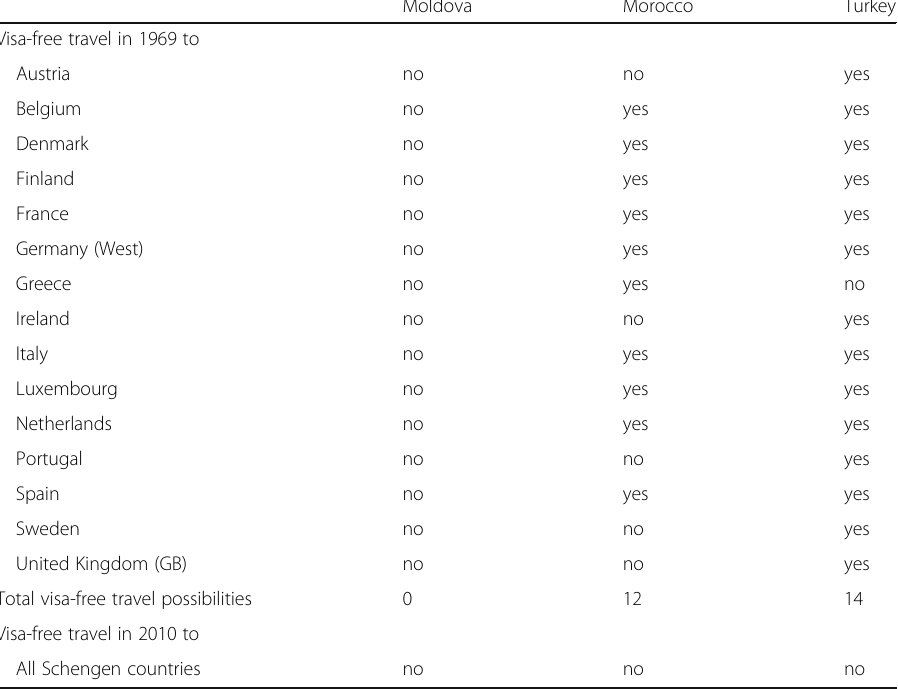
Table 1 Visa-free travel to the EU/Schengen area in 1969 and 2010 for citizens from Moldova, Morocco and Turkey Moldova